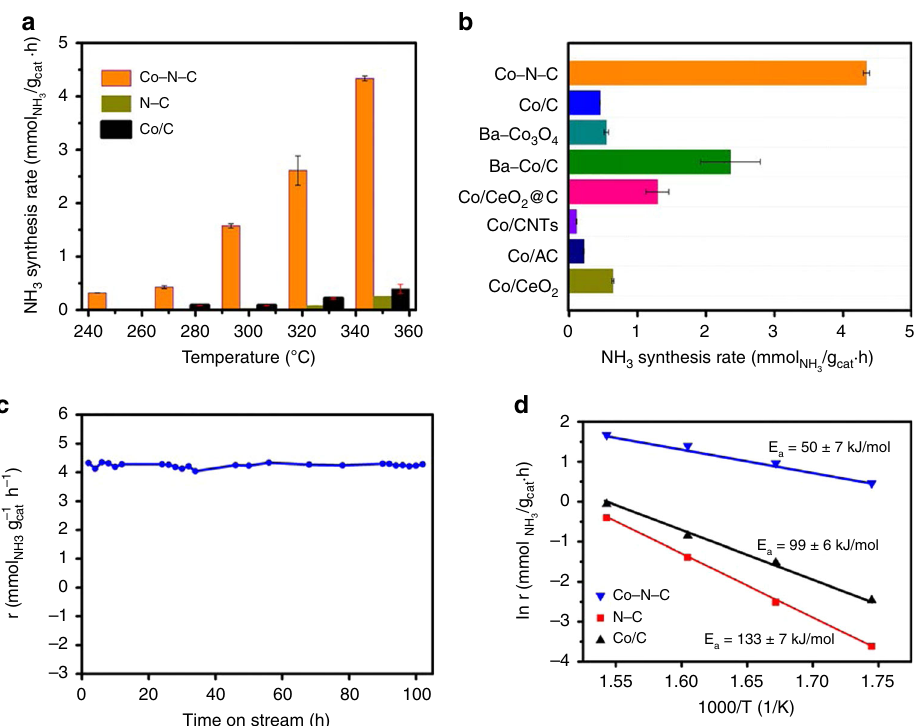
Fig. 2 Catalytic performances. a NH 3 synthesis rate for Co – N – C, Co/C, and N – C under 1 MPa and b NH 3 synthesis rate of selected catalysts at 350 °C under 1 MPa (The data points and error bars represent the average and standard deviation based on multiple measurements on the same catalyst at different times over different batches of samples). c Time course of NH 3 synthesis rate at 350 °C over Co – N – C and d Arrhenius